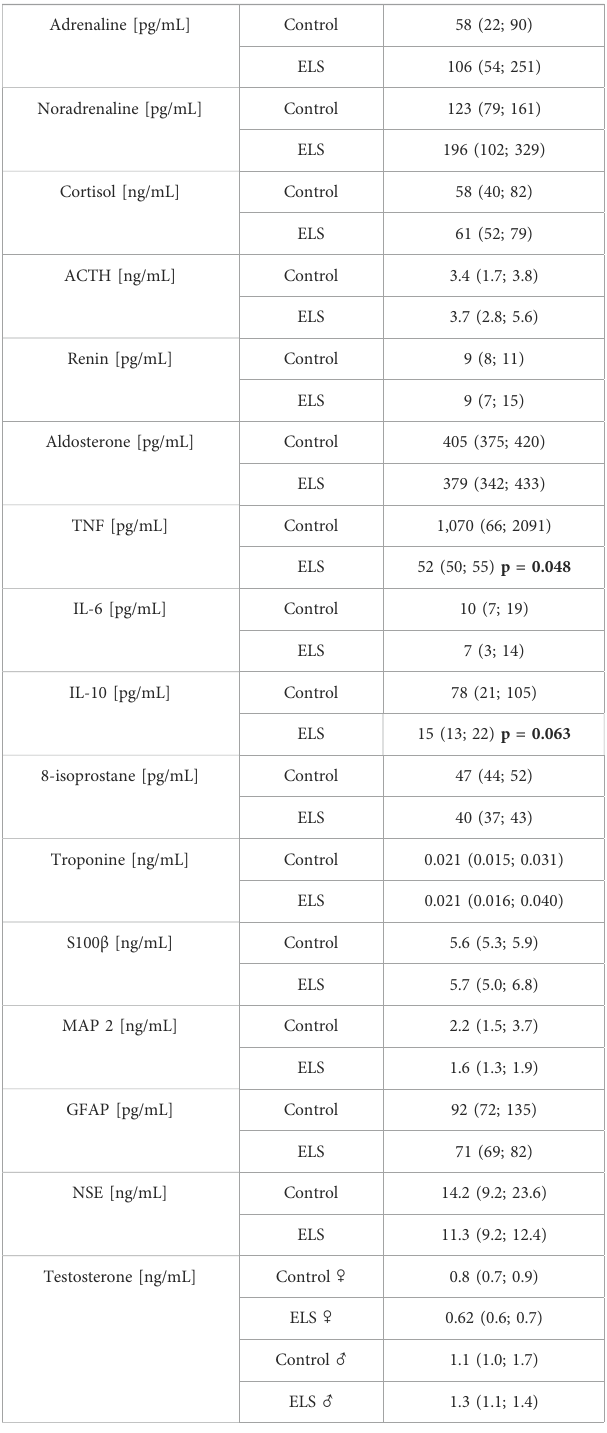
TABLE4Plasmaconcentrationsofcatecholamines(adrenaline,noradrenaline), cortisol, adrenocorticotropic hormone (ACTH), renin, aldosterone, cytokine (tumor necrosis factor (TNF), interleukin-6 and -10 (IL-6 and -10)), 8- isoprostaneand “ serumbraininjurymarkers ” (microtubule-associatedprotein 2 (MAP-2), glial fi brillary acidic protein (GFAP), neuron-speci fi c enolase (NSE), protein S100 β (S100 β )) and testosterone in the control and Early Life Stress (ELS) groups (n = 6 each). All data are median (interquartile range) except for testosterone (median (minimum and